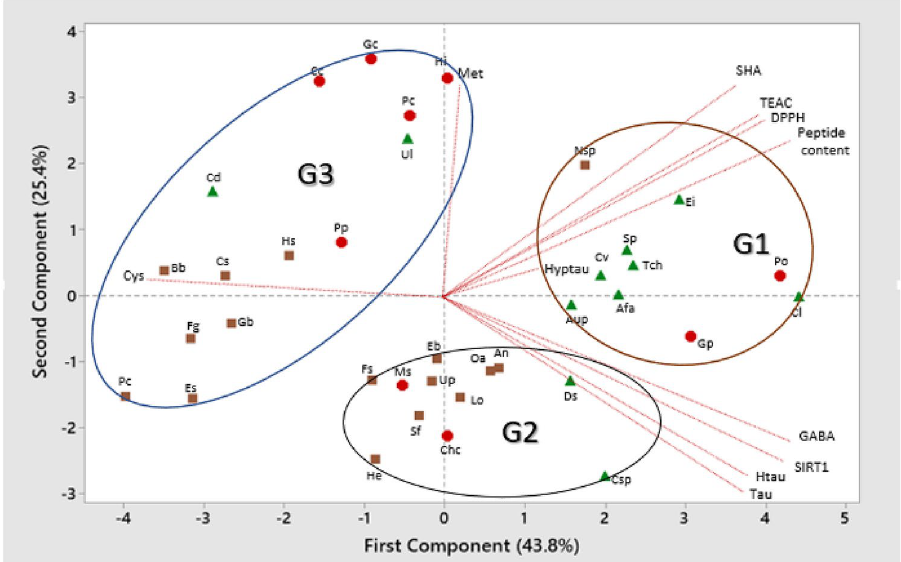
Figure 3. Principal Components Analysis of EPHs from 36 algae samples. Met = Methionine; SHaas = Sum of hydrophobic amino acids; DPPH and ABTS = antioxidant activities; SIRT1 = Sirtuin 1 inhibition/activation activity; GABA = Gamma amino butyric acid; Tau: taurine; Htau: Homotaurine; Hyptau: Hypotauine; Cys: Cysteine. Circles, squares, and triangles represent red, brown, and green algae species, respectively. Abbreviations of algae species as listed in Table